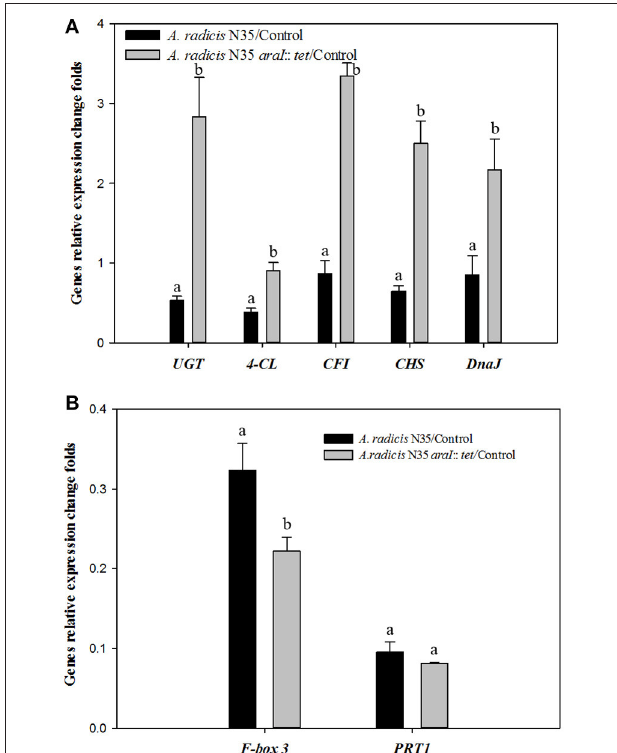
FIGURE 5 | q-PCR analysis of the expression of genes under the influence of A. radicis N35 wild type and the araI mutant. Barley seedlings were not inoculated (control, CK) or inoculated with A. radicis N35 wild type or the araI mutant, respectively. Cultivation was performed monoxenically for 10 days (see MM). Then one leaf was taken at the three leaves stage, RNA was isolated, q-PCR from transcribed cDNA was performed. Statistical analysis was performed using one way ANOVA ( p ≤ 0.05). Different letters indicate significant differences among treatment groups. (A) Flavonoid biosynthesis pathway genes: 4-coumarate CoA ligase (4-CL), chalcone-flavonone isomerase (CFI), chalcone synthase (CHS), UDP-glycosyltransferase-like protein (UGT); and chaperone protein (DnaJ). (B) Fb-3, F-Box family-3 and E3 ubiquitin-protein ligase